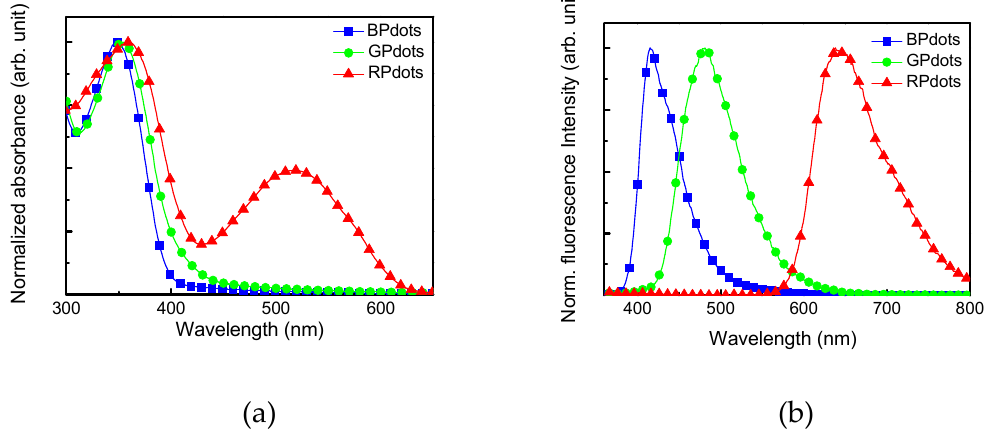
Figure 2. ( a ) UV-vis and ( b ) fluorescence spectra of Pdots in water. Excitation wavelength 350 nm. The DLS measurements of Pdots indicated the hydrodynamic diameters to range from 89 to 130 nm and zeta potentials from − 11 to − 19 mV (Table 2). Because of the presence of the carboxylic acid group on the Pdot surface, the zeta potentials were found to be negative. For further use in linking with NIPAM, AA was introduced to the NP surface by reacting the carboxylic acid moieties of Pdots with AA to form an amide linkage with the aid of EDC and NHS, providing an allyl group (Scheme 2). After the introduction of AA, the NP size remained unchanged, while the zeta potentials of three Pdots@AA changed, because of the transformation of the negatively charged carboxylic acid groups to the allyl groups (Table 2). SEM images of BPdots@AA indicated that the spherical shape of the BPdots was maintained even after AA functionalization (Figure S2). GPdots and RPdots and their AA modified Pdots also showed spherical shapes. The presence of the AA moiety was confirmed by FT-IR and EDS (Figures S3 and S4). In the IR spectra, the characteristic bands of allyl CH=CH 2 and N-H amide bond were observed at 831 and 1568 cm − 1 , respectively. The EDS mapping images were investigated to determine the N content of the NPs. As expected, N was not found in BPdots, but BPdots@AA showed the presence of N. The UV-vis absorption and fluorescence wavelengths of Pdots@AA were identical to those of Pdots, despite the surface modification with AA (Figure S5). The effect of tem- perature on the hydrodynamic diameters and fluorescence intensity of the three Pdots@AA was investigated and it was found that those of Pdots@AA were not affected by temperature changes (Figure S6). Table 2. DLS Results of Pdots and Pdots@AA. Source